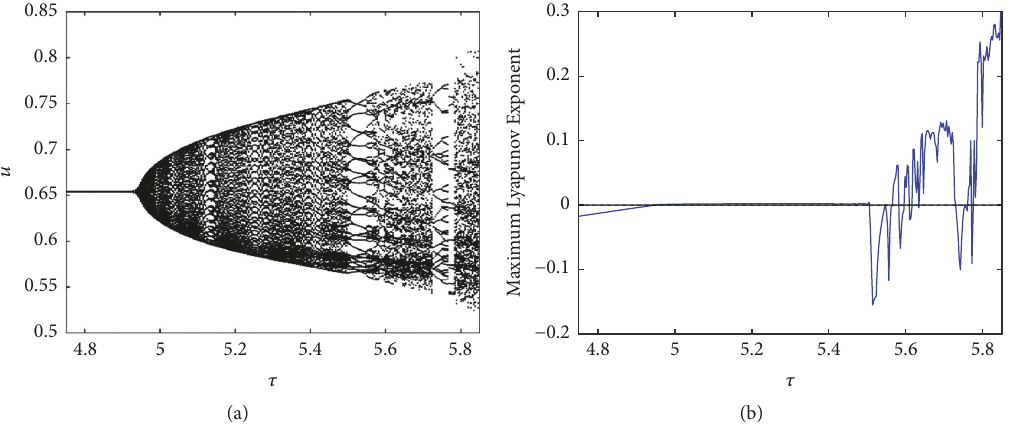
Figure 1: (a) Neimark-Sacker bifurcation diagram and (b) maximum Lyapunov exponent corresponding to (a). a = 1.63, b = 0.1, c = 0.32, and d = 0.22.